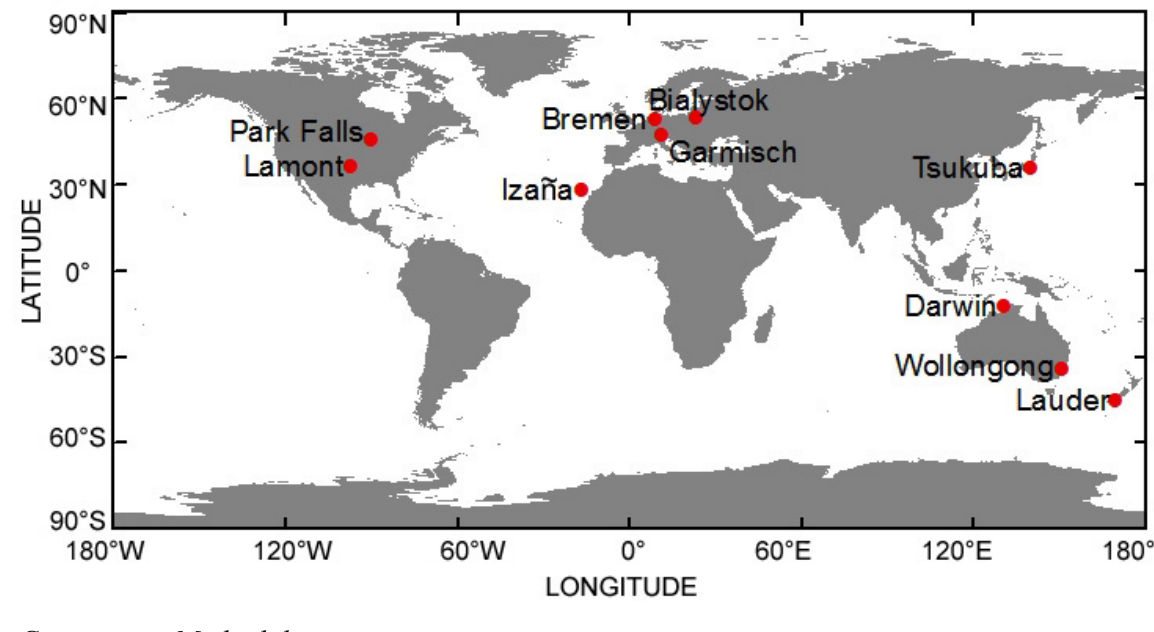
Figure 2. The locations of TCCON sites used in this paper are indicated by red